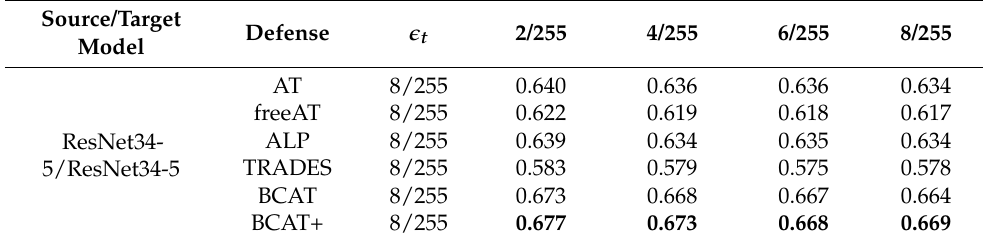
Table 5. Comparing the black-box adversarial robustness generalization accuracy of different defense methods on CIFAR-100.